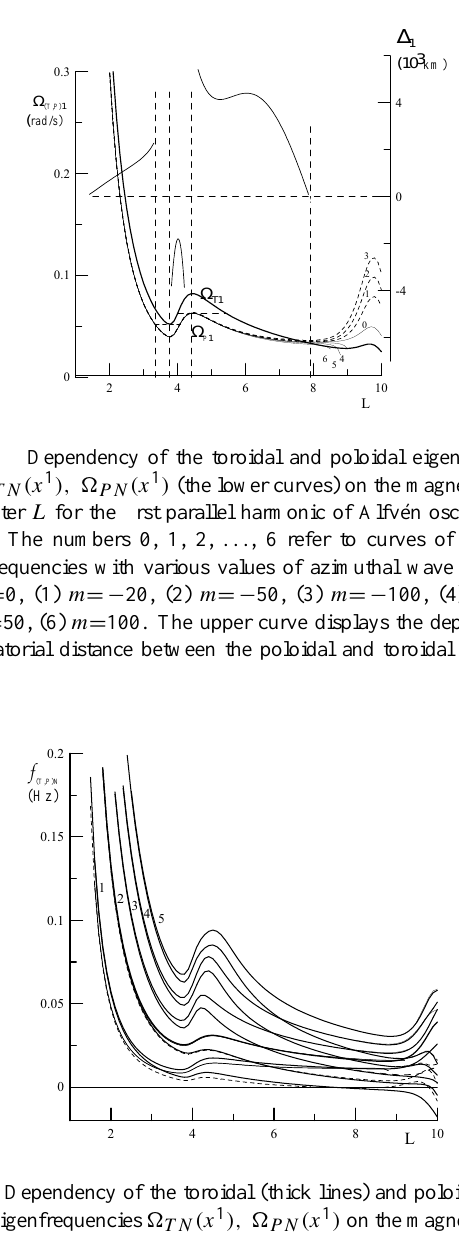
TN harmonics ( ). N=1;2;3